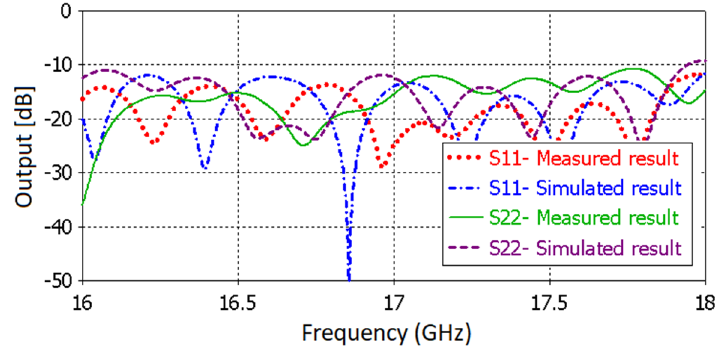
Figure 15. Measured and simulated reflection coefficients of the beam steering antenna system.